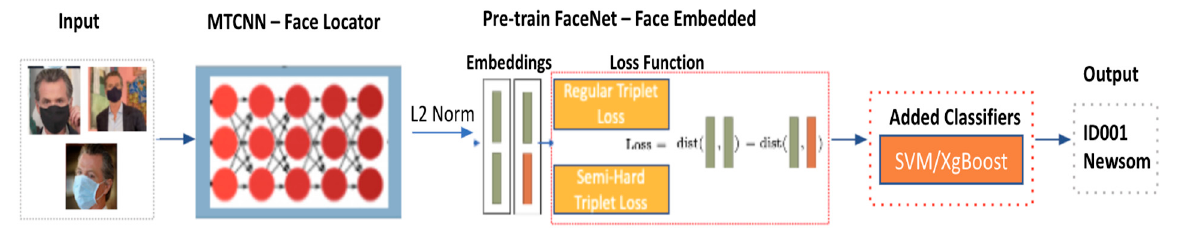
Figure 7. Face Mask Facial Recognition Pipeline.